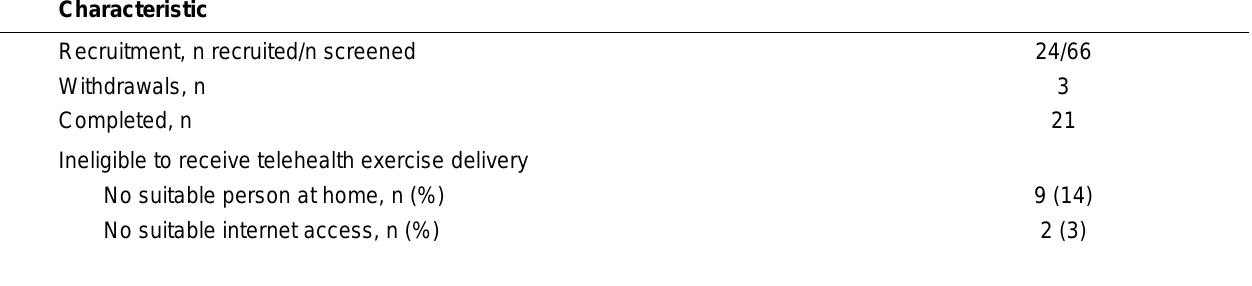
Table 1. Recruitment, Supervision and Adherence of Participants to Telehealth, and the Reliability of Telehealth Delivery